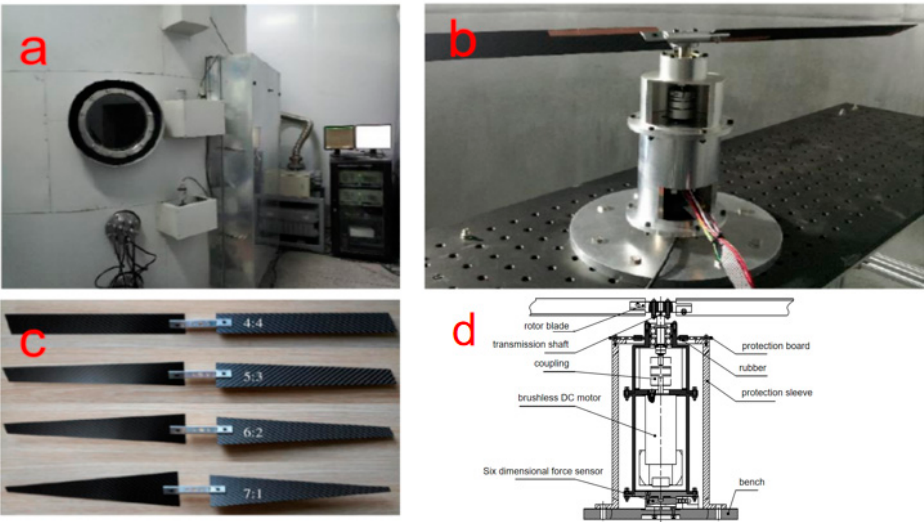
Figure 1. Mars Air Simulator and the experimental setup (( a ) is the MAS, ( b ) is the test set, ( c ) are the tested rotors, ( d ) is the schematic diagram of the test set).